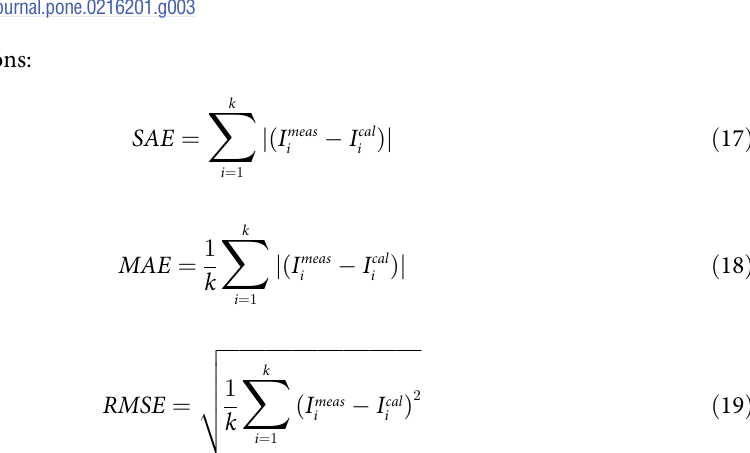
Fig 3. The workspace of the established software application, which is used to extract the PV cells and modules parameters based on ACT.